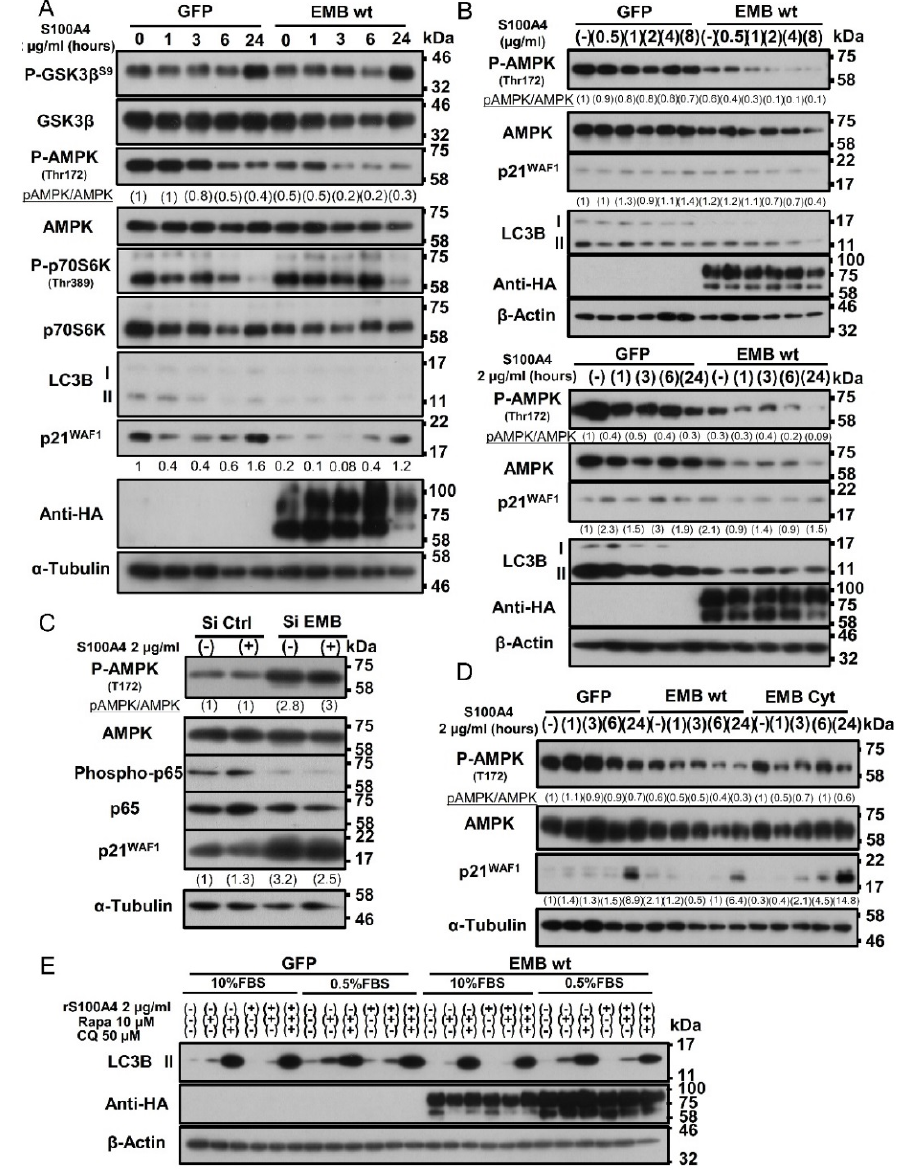
Figure 7. Embigin mediates its biological functions through AMPK/mTOR/p21 signaling and inhibition of autophagy. ( A – D ) Western blot analysis of ( A ) DU145 cells transiently overexpressing GFP and embigin wild ‐ type (wt) that were stimulated with 2 μ g/mL of rS100A4 for 1, 3, 6, and 24 h. Embigin activates mTORC1 signaling as indicated by higher phosphorylation of p70S6K, followed by inhibition of the cell cycle inhibitor p21 and the autophagy marker LC3B ‐ II. ( B ) DU145 cells stably